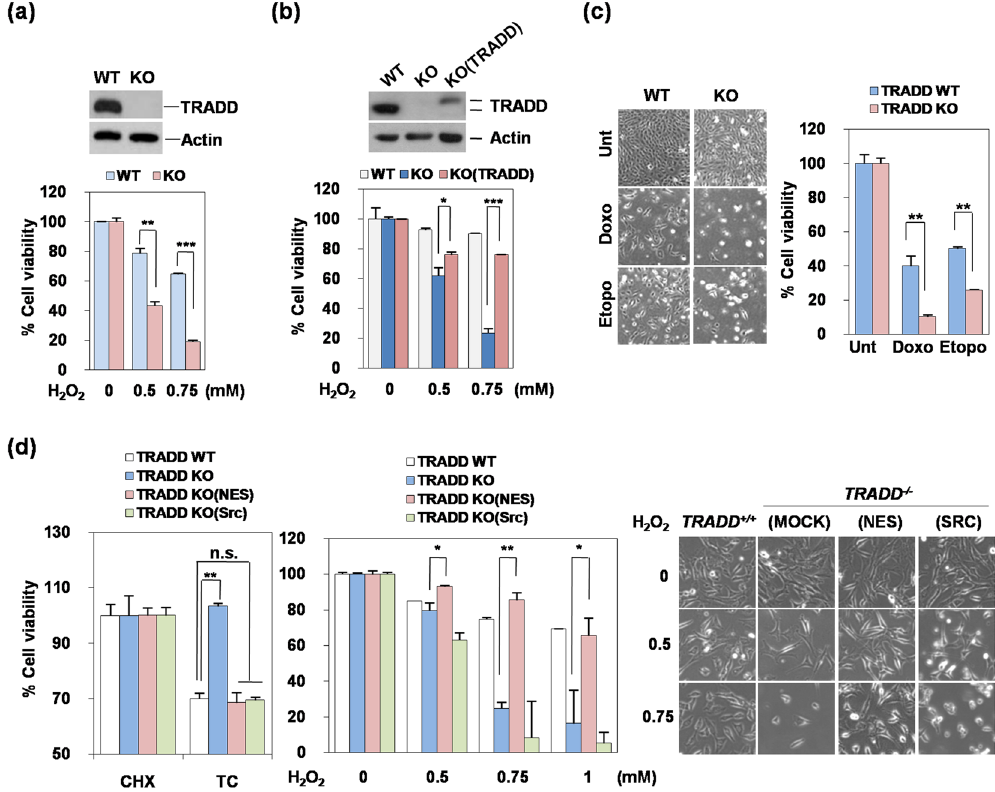
Figure 4. Deletion of TRADD sensitizes to DNA damage agents-induced cell death. ( a ) TRADD + / + (WT) and TRADD − / − (KO) MEFs were treated with H 2 O 2 for 24 hours and then cell viability was analyzed by MTT assay. ** P < 0.01; *** P < 0.001 (Student’s t-test). ( b ) TRADD + / + (WT), TRADD − / − (KO), and TRADD − / − mTRADD (KO-TRADD) cells were treated with H 2 O 2 for 24 hours. Cell viability was analyzed by MTT assay. * P < 0.05; *** P < 0.001 (Student’s t-test). ( c ) Representative images from treatment with DNA-damaging agents in TRADD wild type and knockout MEFs. TRADD + / + (WT) and TRADD − / − (KO) MEFs were treated with doxorubicin (Doxo) and etoposide (Etopo) for 24 hours and then cell viability was analyzed by MTT assay. ** P < 0.01 (Student’s t-test). ( d ) Representative images rescued with TRADD WT, KO, KO (NES), or KO (Src) in knockout MEFs of TRADD. MTT assay of TRADD WT, KO, KO (NES), and KO (Src) MEFs treated with H 2 O 2 and TNF (30 ng/mL) plus CHX (2.5 μ g/mL) for 24 hours. * P < 0.05; ** P < 0.01; n.s., not significant (Student’s